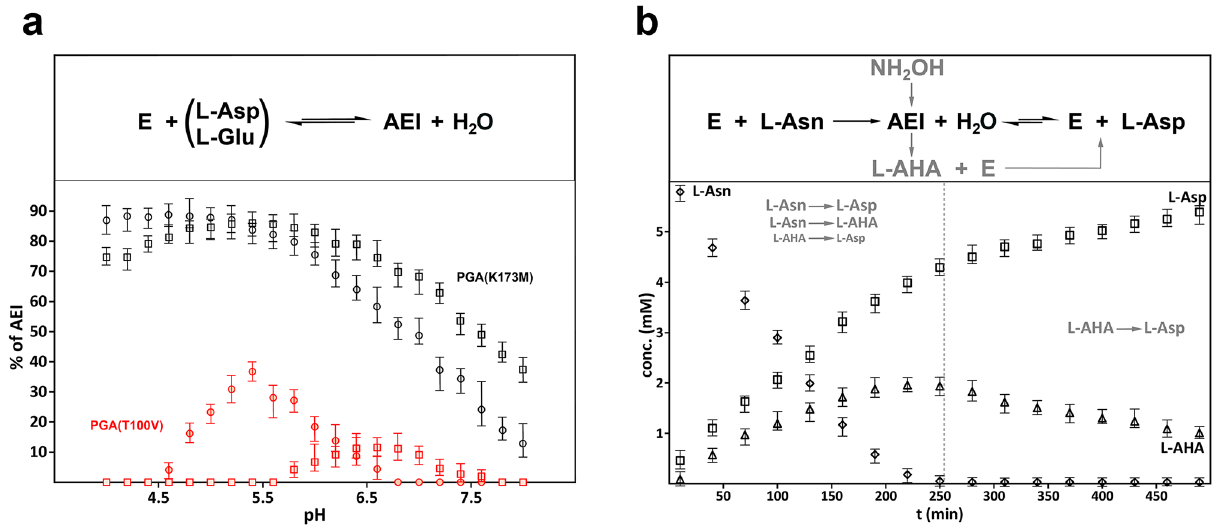
Figure 1. Mass Spectrometry studies of reactions between PGA and its substrates. Formation of covalent acyl-enzyme intermediates (AEI) in mixtures of L-aspartic (or L-glutamic) acid with either PGA(K173M) or PGA(T100V) at different pH values, measured by Single Quad LC/MS, is illustrated in panel ( a ). The equilibria present in each mixture are shown at the top of this panel. Resulting data points, obtained for solutions containing PGA(K173M) and PGA(T100V) are colored in black and red, respectively. Values recorded for experiments with L-Glu are marked by squares and those obtained in mixtures containing L-Asp by circles. Each data point represents an average from three independent measurements and the range of individual readings is represented by vertical error bars. Content of AEI (% AEI) was calculated according to the formula (% AEI = abundance of AEI [%])/{(abundance of AEI [%]) + (abundance of EcAII(K162M) [%])}. Progress of L-Asn hydrolysis by PGA(wt) in the presence of an external nucleophile (NH 2 OH) is shown in panel ( b ). At each time point, concentrations of substrate (L-Asn), product (L-Asp), and byproduct (L-AHA) were determined by Q-TOF LC/MS as described in Materials and Methods. Concentrations of L-Asn, L-Asp and L-AHA are marked by diamonds, squares, and triangles, respectively. Vertical dashed line indicates the time at which all L-Asn was converted to either L-Asp or L-AHA. The reactions taking place prior this time are listed on the left of the dashed line, in gray font. The irreversible reaction taking place in the absence of L-Asn is shown to the right of the dashed line. Relationship between reactions taking place during this experiment is illustrated at the top of this panel. Since this assay was conducted at pH 7.7, equilibrium between L-Asp and L-AHA is negligible (see panel a ). Each data point represents an average from three independent measurements, with the ranges of individual readings represented by vertical error bars. Figure was prepared with the licensed programs Microsoft Excel and Adobe Photoshop CC